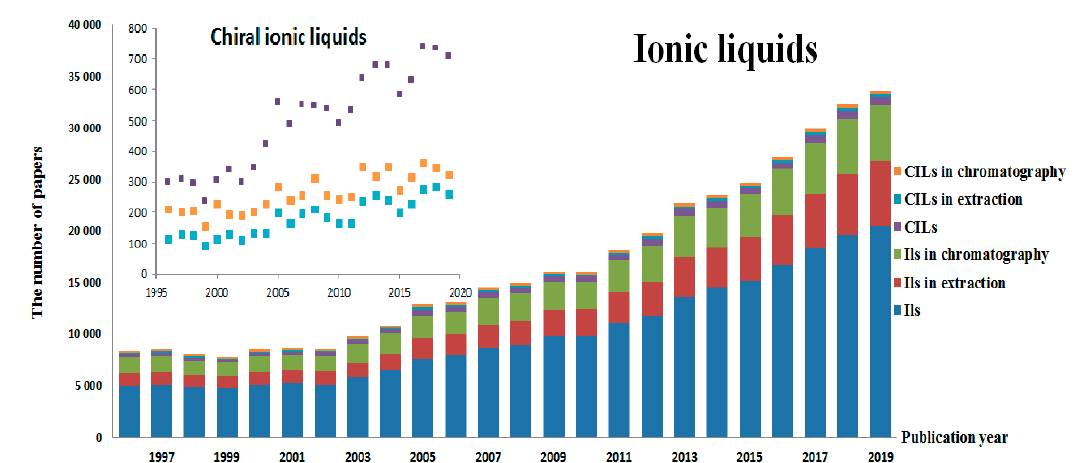
Figure 1. Number of published scientific papers on ionic liquids (ILs) and chiral ionic liquids (CILs) and their applicability in the field of extraction and chromatography depending on the year of their publication (1996–2019), based on the Science Direct database.